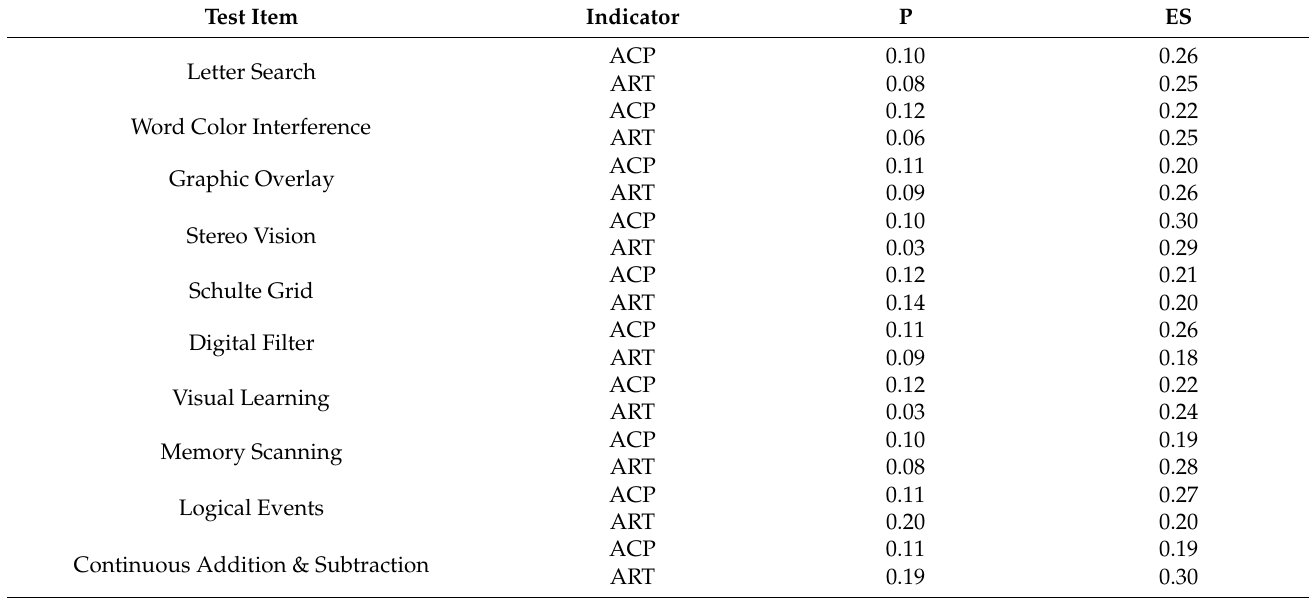
Table A6. The final results of the P and ES of the relevant test